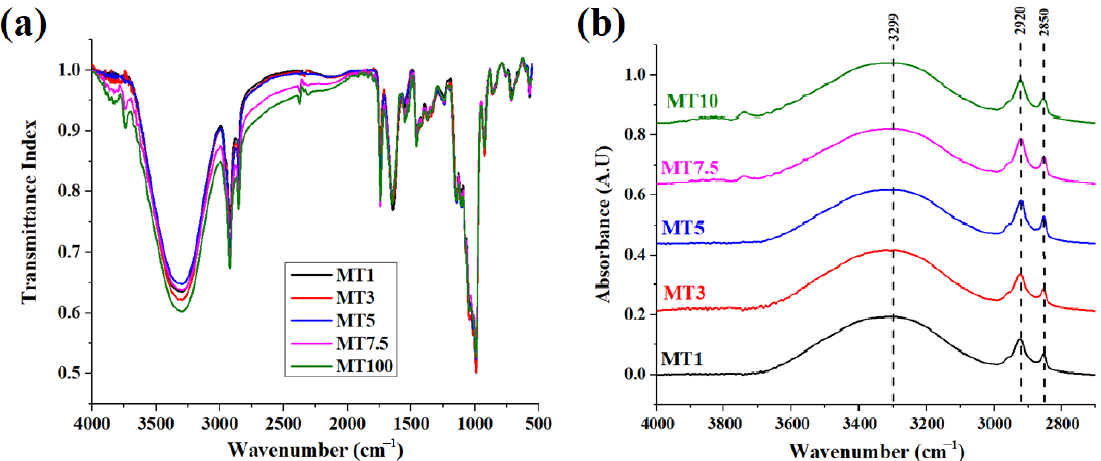
Figure 5. Graphs representing ( a ) FTIR spectrum of dough samples and ( b ) Absorbance spectrum of water region in the range of 4000–2800 cm − 1 .